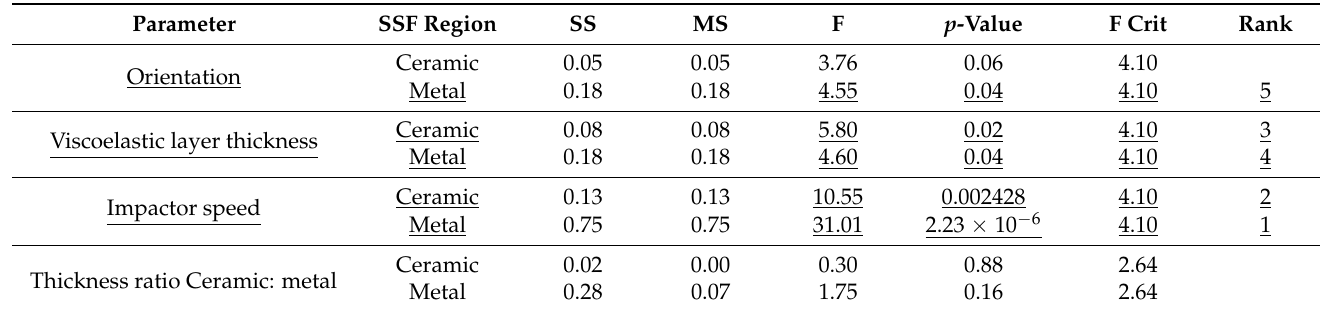
Table A6. Metal–Viscoelastic–Ceramic SSF. Statistically significant parameters are